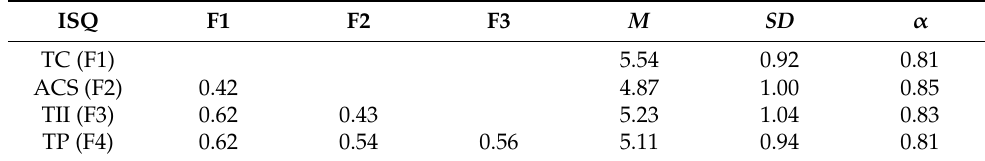
Table 3. Interfactor correlations, means, standard deviations, and Cronbach’s α . ISQ